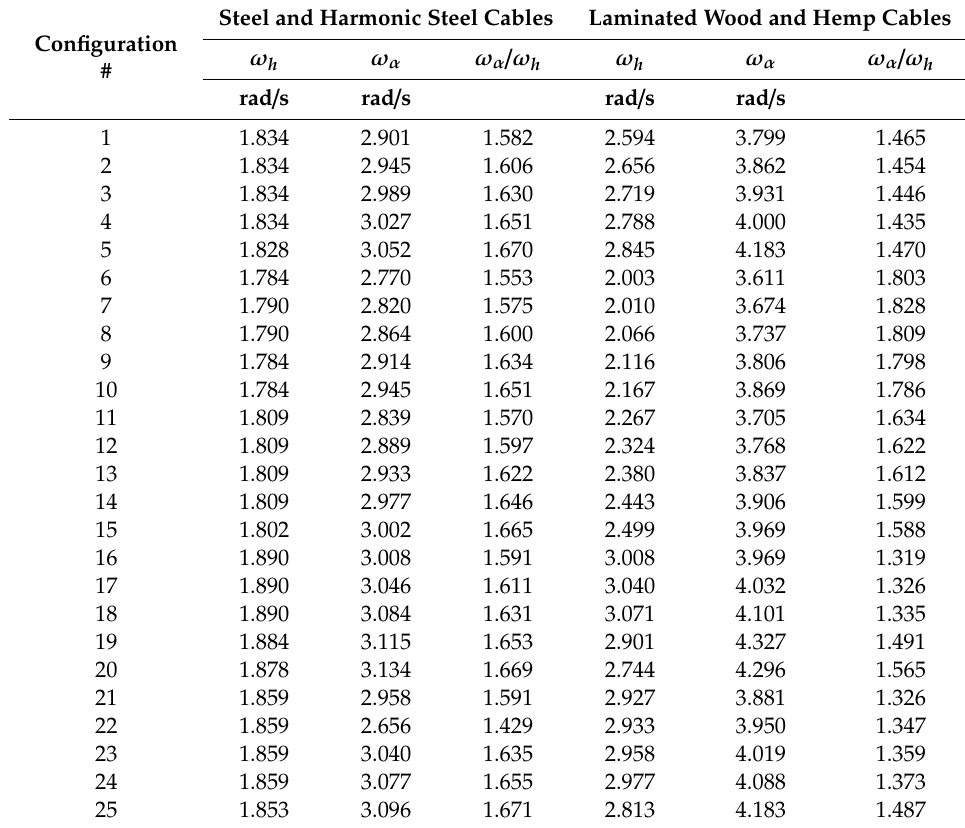
Table 4. First vertical and torsional natural frequencies